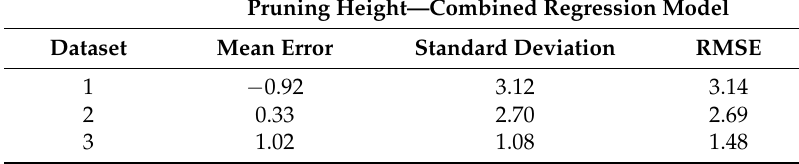
Table 9. Accuracy assessment of pruning height regression model for every dataset: Mean errors, standard deviations and Root-mean-square errors (RMSE).